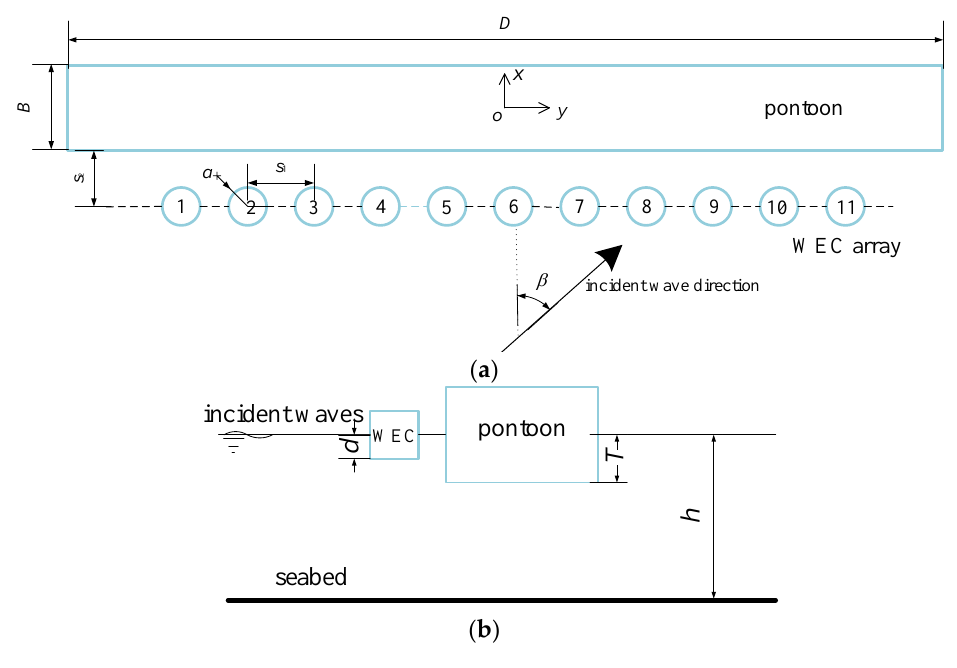
Figure 1. The sketch of the proposed WEC-pontoon system: ( a ) the top view; and ( b ) the side view (the WECs in the array are labelled as devices #1–#11, respectively, on the top view).